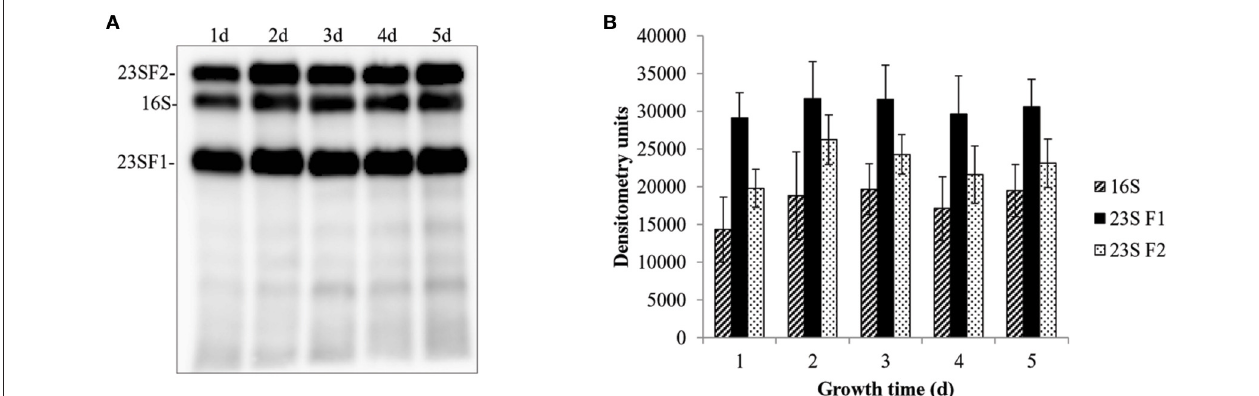
FIGURE 10 | Differential levels of C. burnetii rRNA species during growth. Levels of 16S rRNA and two fragments of 23S rRNA (23S F1 and 23S F2) were determined by Northern blot analyses. (A) Representative example of a Northern blot showing 23S F2, 16S rRNA, and 23S F1 performed on total RNA isolated from C. burnetii cultured for 1–5 d in ACCM-2 (In each case, 100 ng of total RNA and 0.05mM probes were used). (B) Densitometric analysis of 16S rRNA (striped bars), 23S F1 (black bars), and 23S F2 (white, speckled bars). Values represent the means ± S.D. of the result of 3 independent Northern blot analyses from 2 different RNA